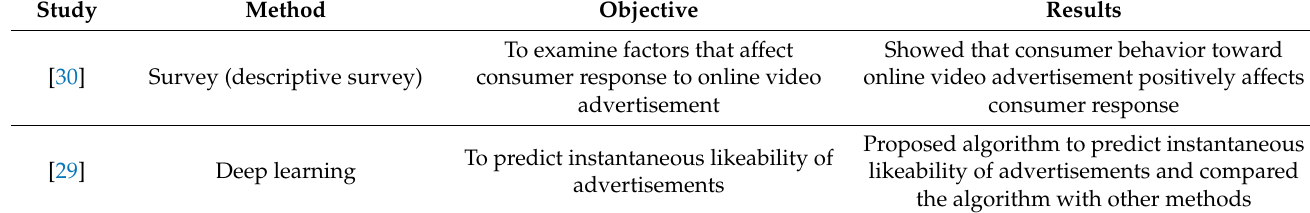
Table 1. Previous Studies on Online